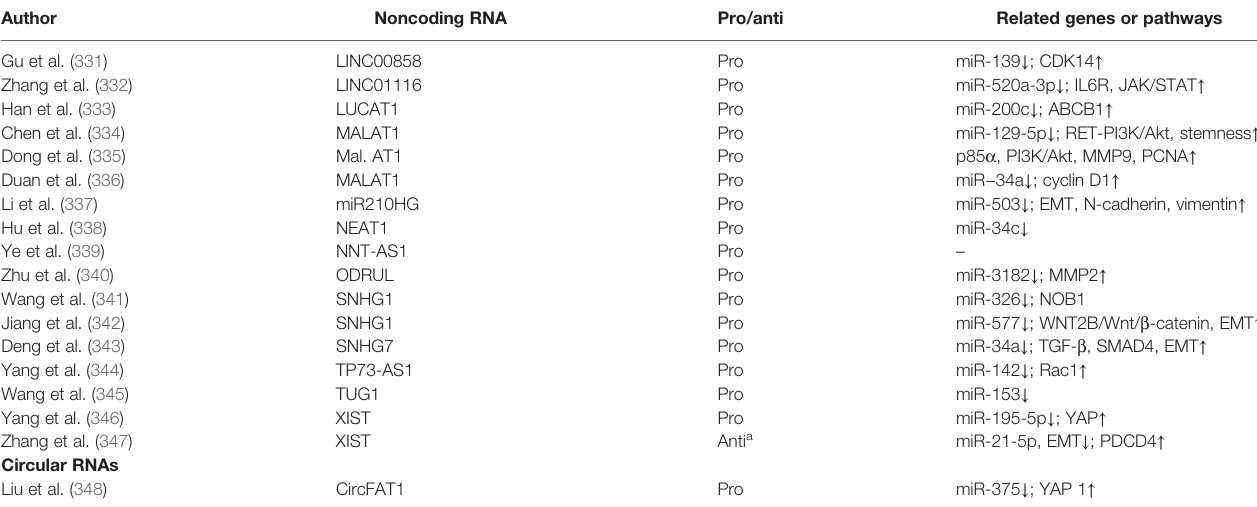
Studies using animal models of osteosarcoma metastasis are included. Pro, the target gene promotes metastasis; anti, the target gene inhibits metastasis; “ ↑ ” upregulation; “ ↓ ” downregulation. a The results in this article is contrary to that of the previous